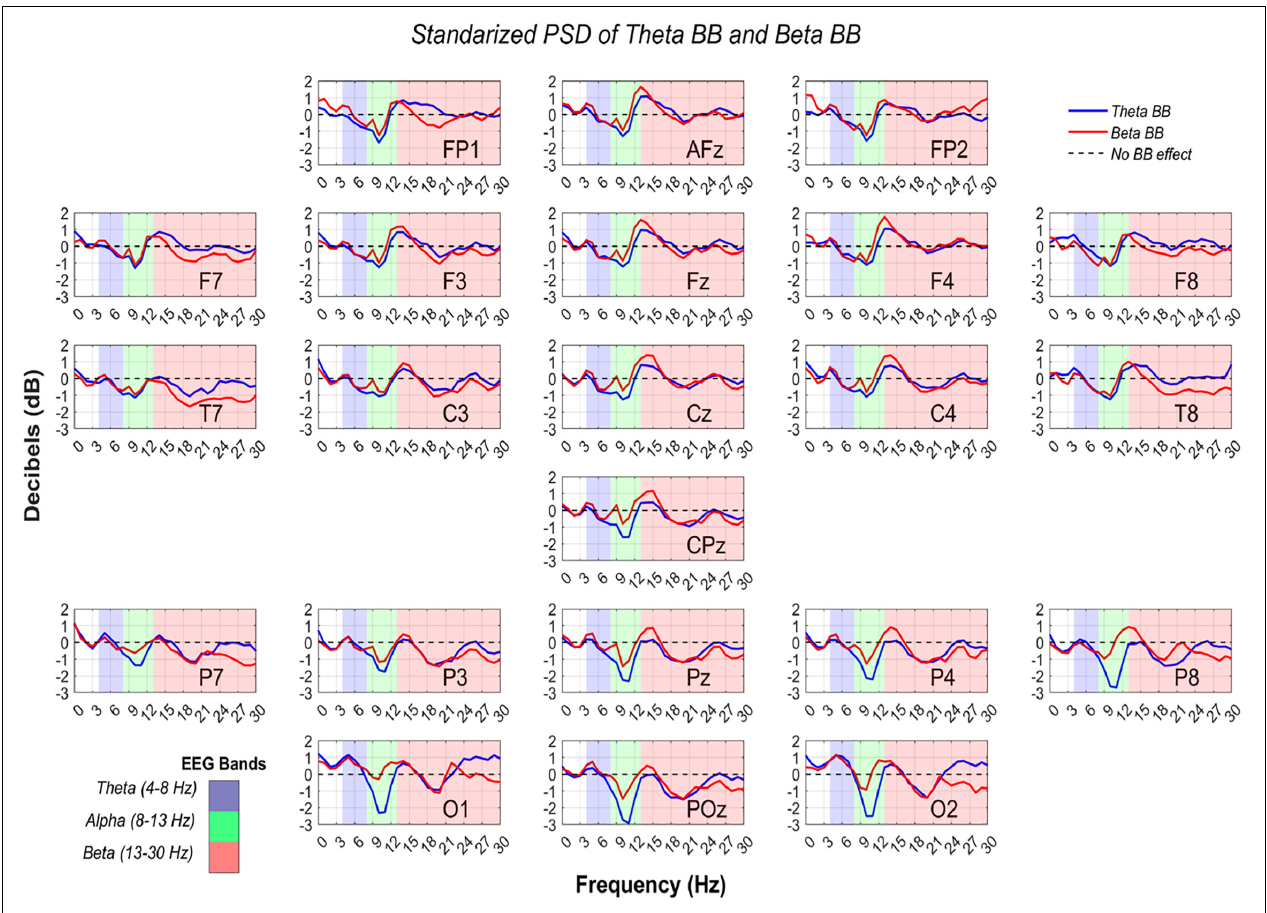
FIGURE 7 | Power spectral density from theta and beta BB, regarding resting state. RP values from theta BB (blue solid line) and beta BB (red solid line) are shown, where X -axis is depicted by frequency ranging from 0 to 30 Hz and Y -axis is the averaged power ratio between S1/S R and S2/S R in dB. Every plot represents a different channel, which was labeled in the lower-right corner. Measurements are highlighted in blue for the theta band, in green for the alpha band, and in red for the beta band.